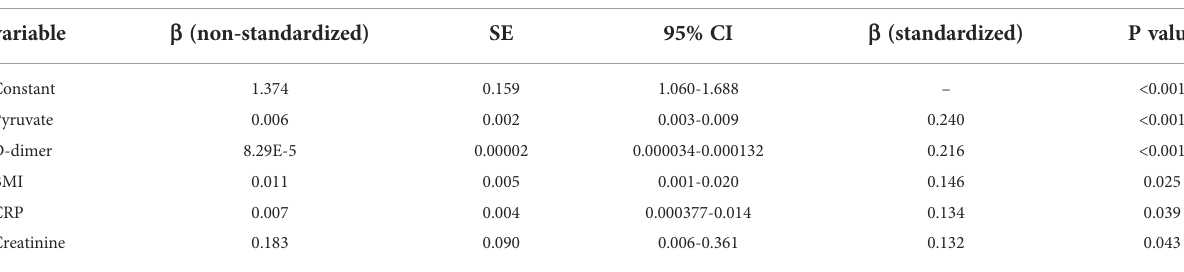
TABLE 3 Clinical, analytical and anthropometric variables related to COVID-19 severity. COVID-19 severity (R = 0.452; R 2 =